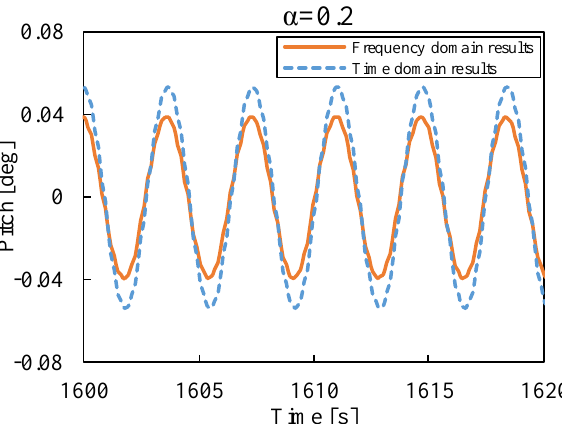
( a ) Comparison of the pitch motions by the time and ( b ) Comparison of the pitch motions by the time and frequency domain models for the artificial damping ratio frequency domain models for the artificial damping ratio of 0.05 of 0.1